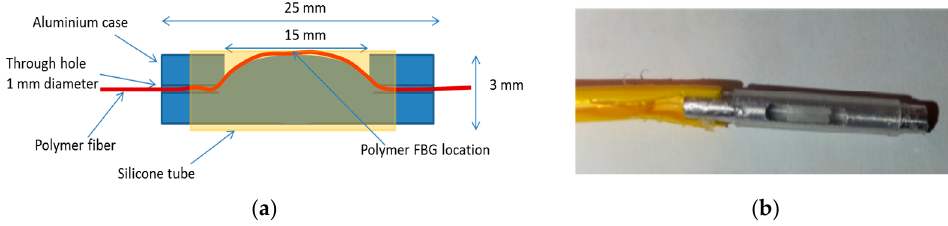
Figure 10. ( a ) Design of the pressure transducer; ( b ) developed prototype of the transducer.